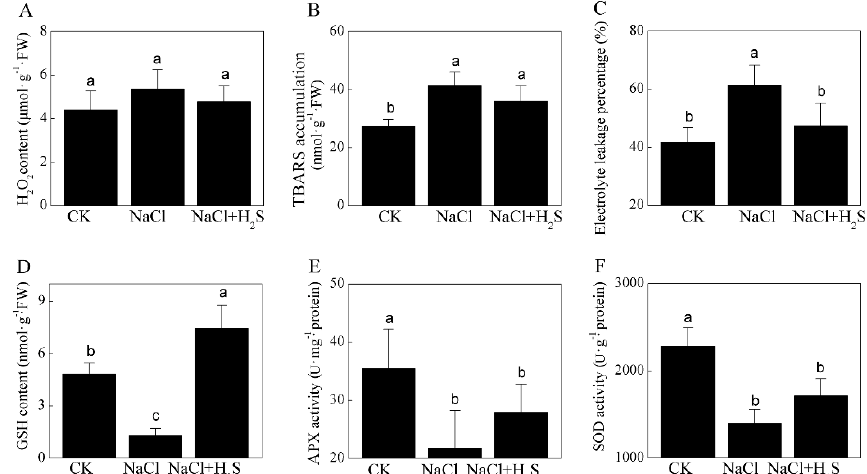
Figure 2. Effects of NaHS on oxidative stress and antioxidant system activity of the leaves of K. obovata seedlings treated by high salinity. ( A ) H 2 O 2 content, ( B ) thiobarbituric acid reactive substances (TBARS) accumulation, ( C ) electrolyte leakage percentage (REL), ( D ) glutathione (GSH) content, ( E ) ascorbate acid peroxidase (APX) activity and ( F ) superoxide dismutase (SOD) activity. CK stands for the control treated only by a 1/4 strength Hoagland’s nutrient solution. NaCl stands for the 400 mM of the NaCl treatment. NaCl and H 2 S stands for the treatment with 400 mM of NaCl and 200 μ M of NaHS. Error bars are SE ( n = 3). The columns labeled with different letters are significantly different at p < 0.05 according to Duncan’s multiple range test.